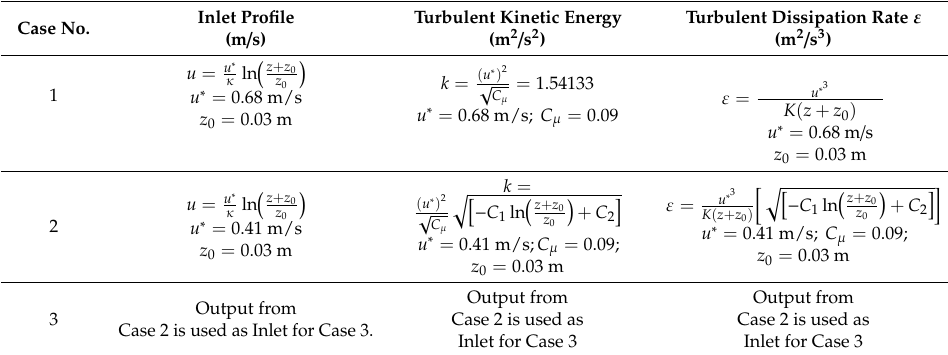
Table 2. Inlet Boundary Conditions for the Three Simulation Cases in all Three Software.